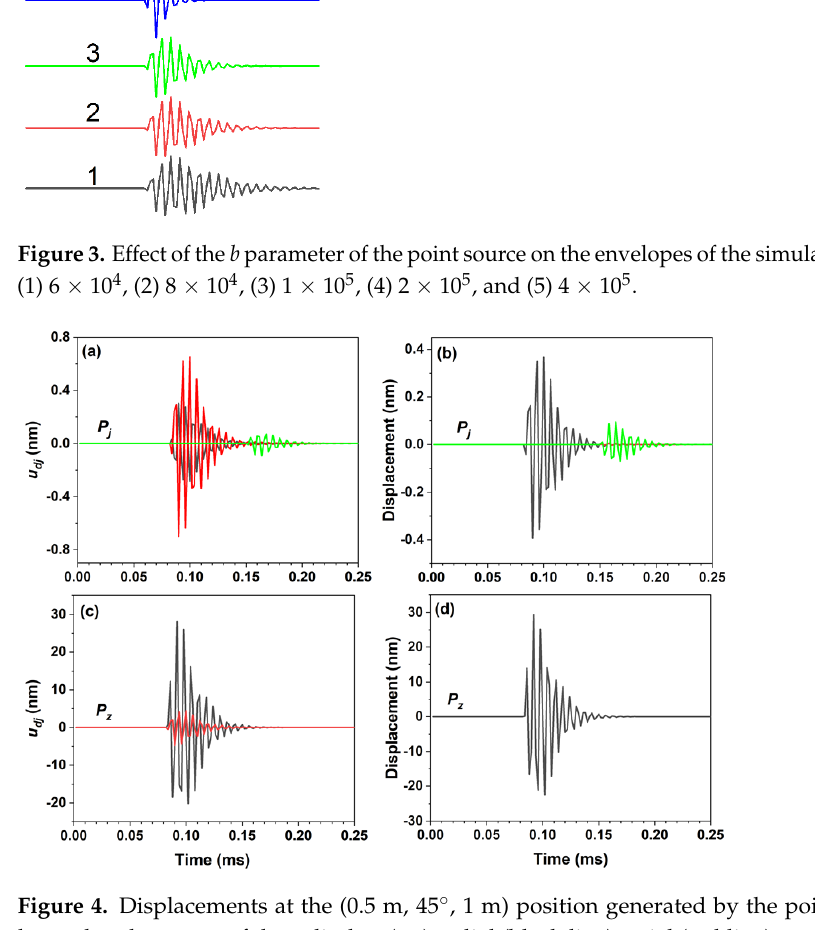
Figure 4. Displacements at the (0.5 m, 45°, 1 m) position generated by the point source of 1.0 N located at the center of the cylinder: ( a , c ) radial (black line), axial (red line), and tangential (green line) components; and ( b , d ) compression P (black line) wave and vertically polarized (SV, red line) and horizontally polarized (SH, green line) shear waves.